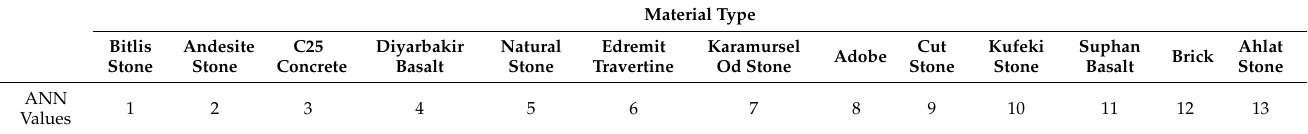
Table 10. Representation of different types of materials in the ANN network.